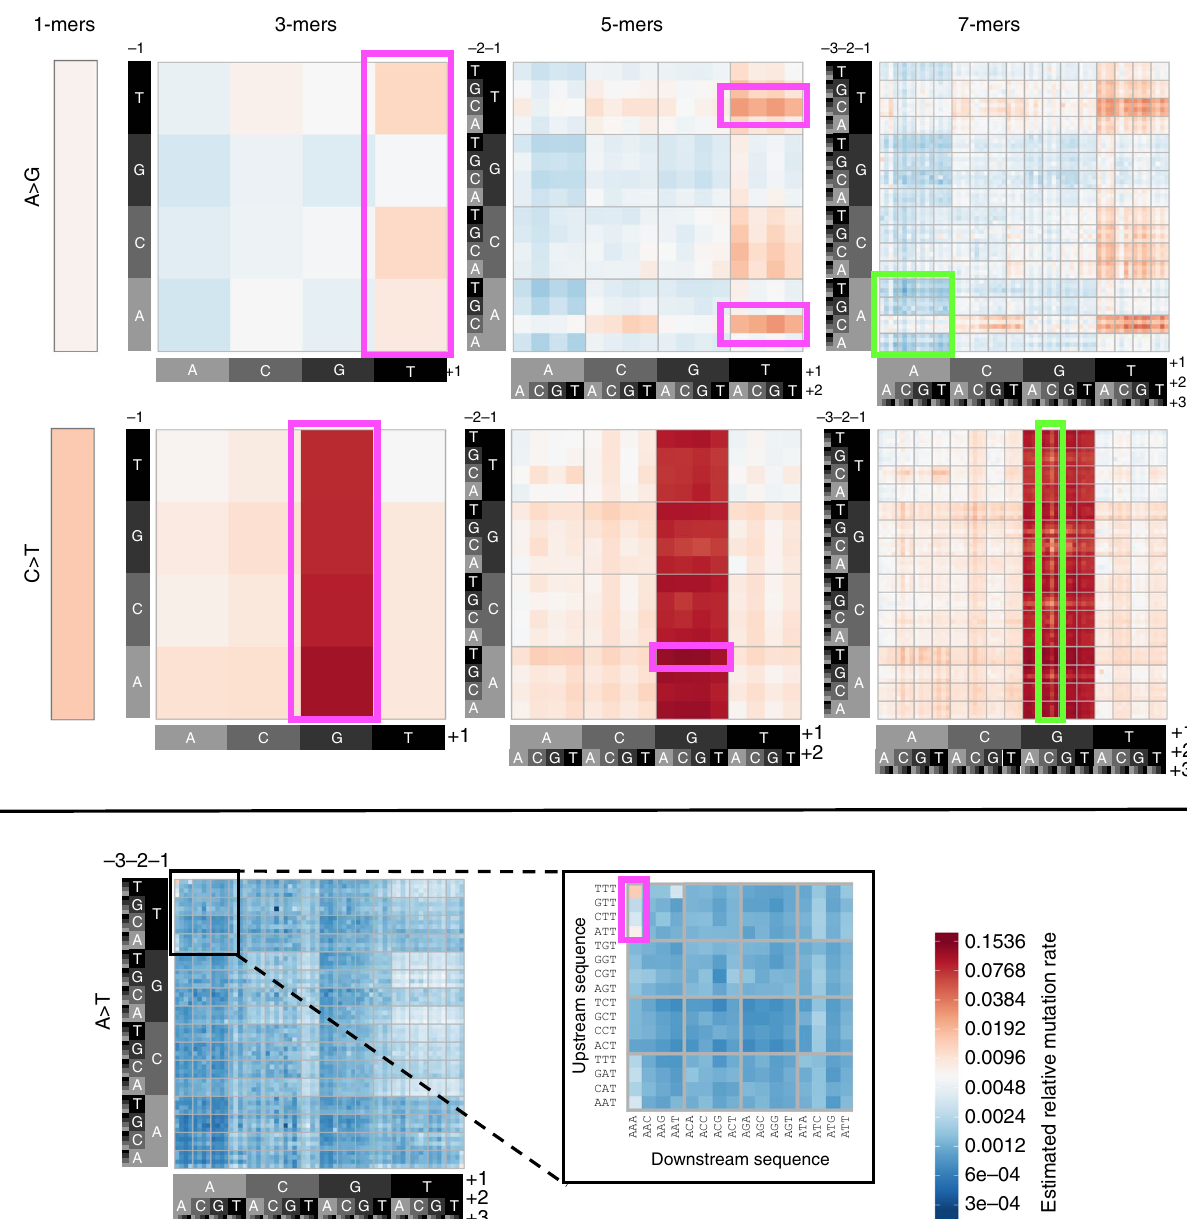
Fig. 1 Mutation rates vary according to sequence context. a Heatmap of estimated relative mutation rates for all possible for A > G and C > T transition subtypes, up to a 7-mer resolution (high-resolution heatmaps for all possible subtypes are included in Supplementary Fig. 1). The leftmost panels show the relative mutation rates for the 1-mer types, and the subsequent panels to the right show these rates strati fi ed by increasingly broader sequence context. Each 4 × 4 grid delineates a set of 16 subtypes, de fi ned by the upstream sequence ( y -axis) and downstream sequence ( x -axis) from the central (mutated) nucleotide. Boxed regions indicate motifs previously identi fi ed by Aggarwala and Voight as hypermutable (pink) or hypomutable (green), relative to their similar subtypes. b Zoomed-in view showing hypermutable NTT[A > T]AAA subtypes relative to other 7-mer A > T